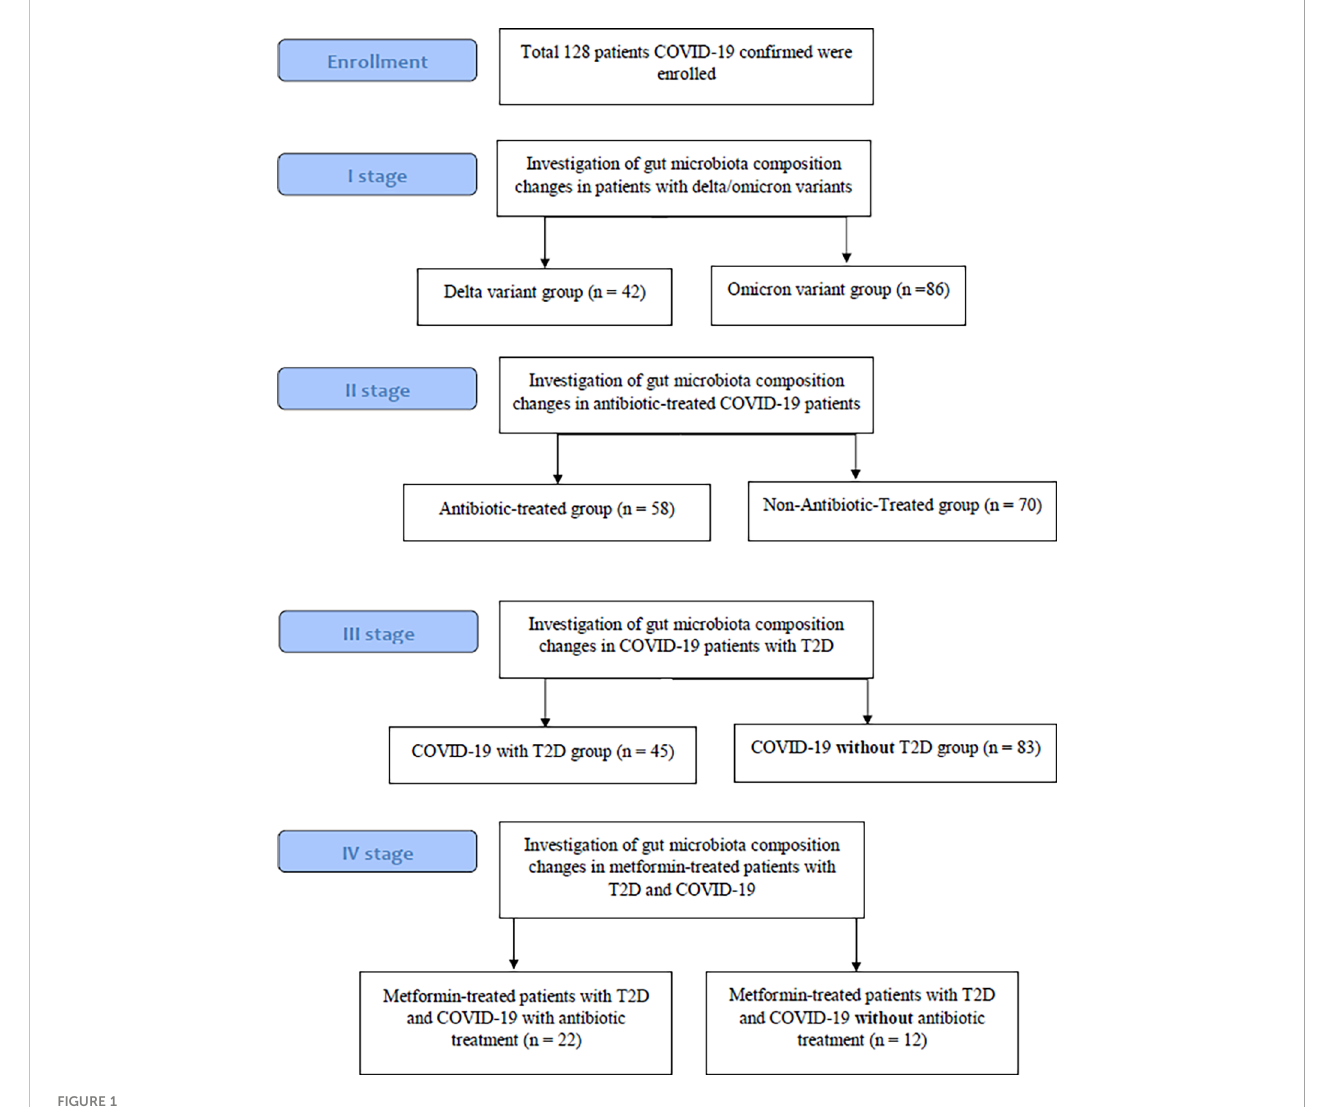
FIGURE 1 Study fl ow